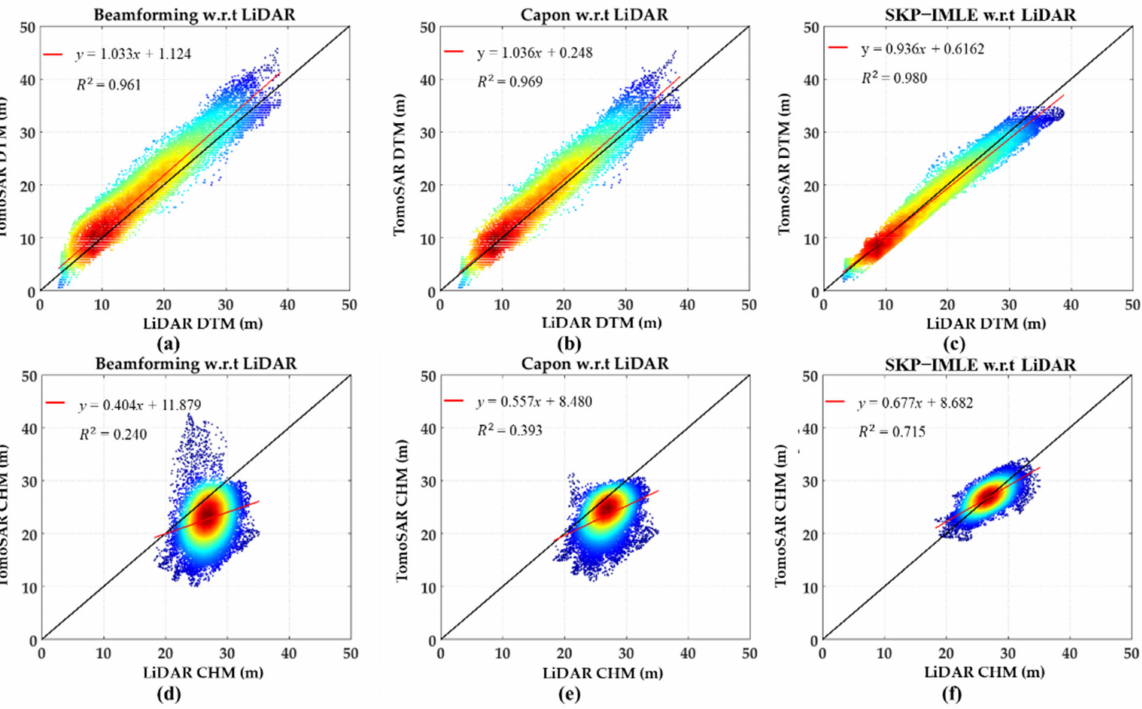
Figure 12. The relationships between the LiDAR and TomoSAR heights in ROI2: ( a ) LiDAR-based DTM and underlying topography by the Pol-beamforming method; ( b ) LiDAR-based DTM and underlying topography by the Pol-Capon method; ( c ) LiDAR-based DTM and underlying topography by the SKP-IMLE method; ( d ) LiDAR-based CHM and forest height by the Pol-beamforming method; ( e ) LiDAR-based CHM and forest height by the Pol-Capon method; ( f ) LiDAR-based CHM and forest height by the SKP-IMLE